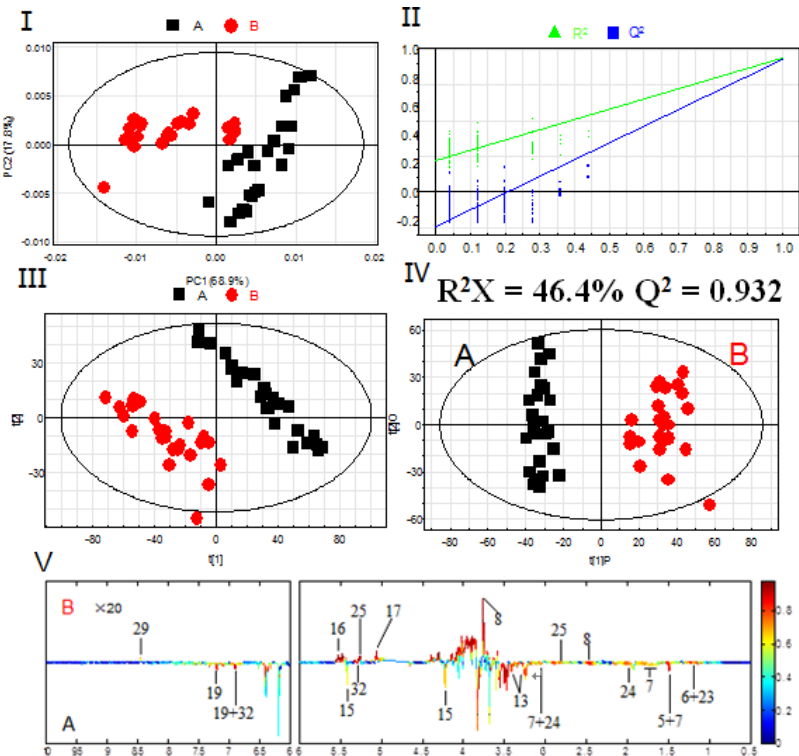
Figure 3. PCA scores plot ( I ); permutation test with 200 permutations of PLS-DA model ( II ); PLS-DA scores plot ( III ); OPLS-DA scores plot ( IV ); correlation coefficients loading plot ( V ) obtained from 1 H-NMR metabolic profiles derived from aqueous methanol fractions of PR from different cultivation fields. ( A ) JSJR; ( B ) FJZR.